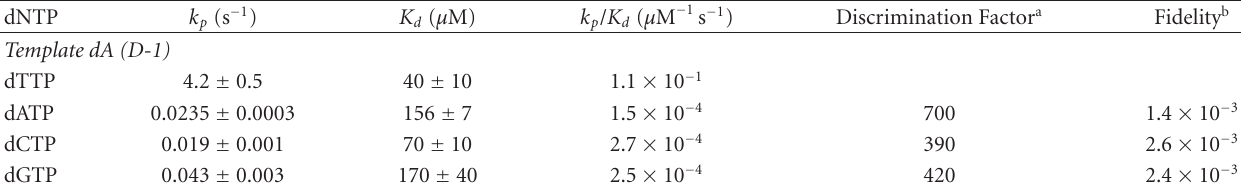
a Calculated as ( k